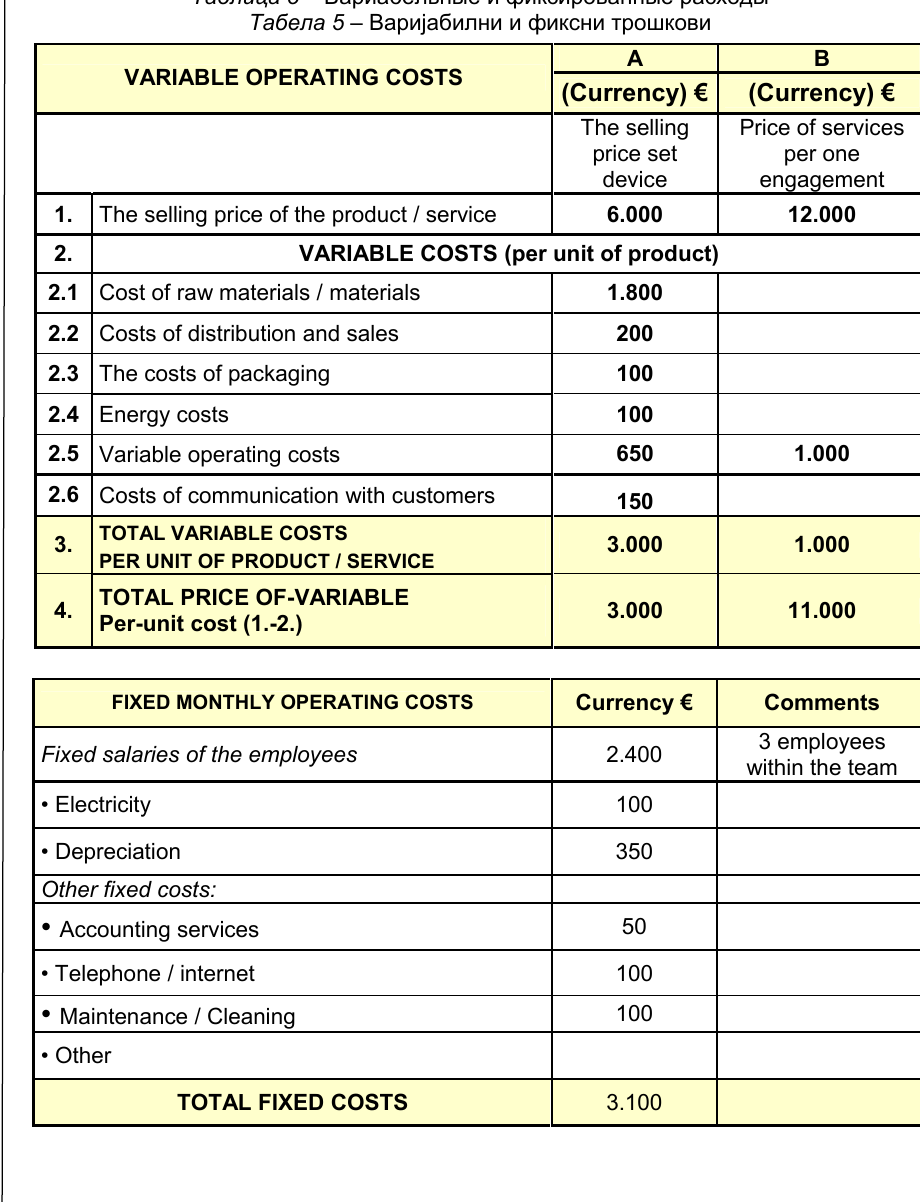
Table 5 – Variable and fixed